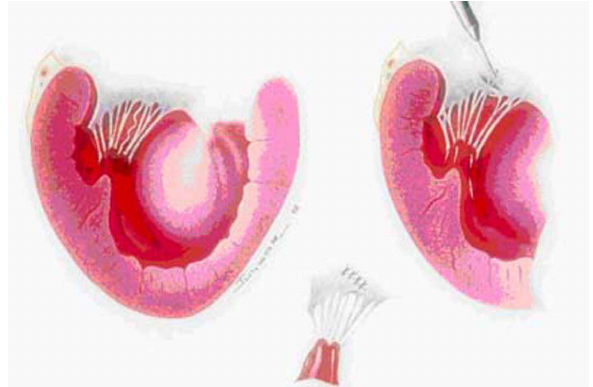
Fig. 1 – Left: schematic illustration shows the elongated chordae. Right: note that the orifice (2 to 3 millimeters wide) is near the edge of the leaflet, at a site corresponding to the insertion site of the elongated chordae. Traction of an elongated chordae through the orifice in the anterior leaflet is observed. The orifice in the anterior leaflet is sutured with interrupted 5-0 polypropylene sutures. Lower: the chordae tendineae are fastened to the atrial surface of the mitral